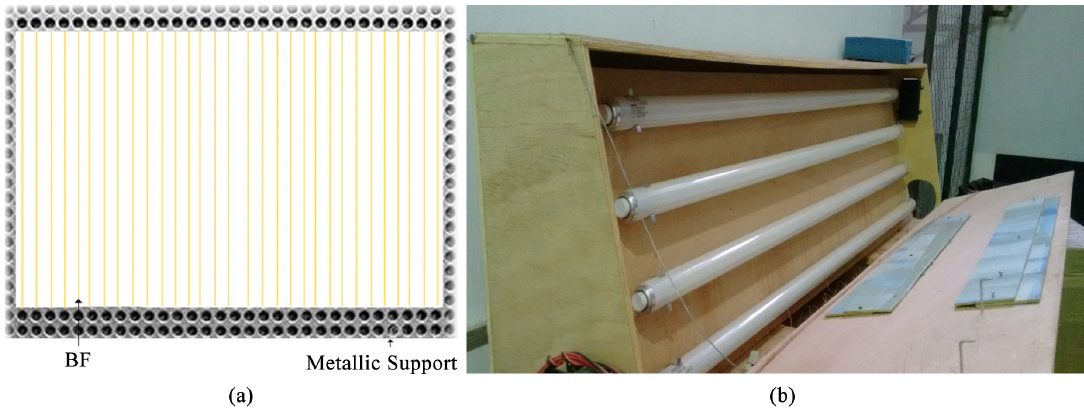
Figure 2. Apparatus used to apply UV radiation on BFs. (a) Representation of the metallic frame to keep the fibers aligned during exposure. (b) Photobleaching chamber build based on ASTM D5208‑09 13 . Bibliographic source: